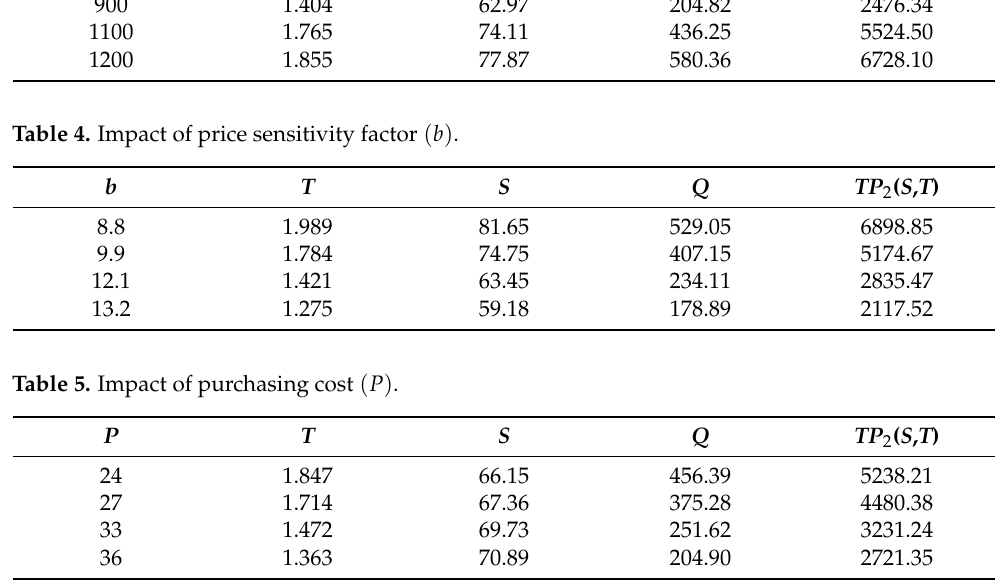
Figure 5. Comparison chart of current model with [28].